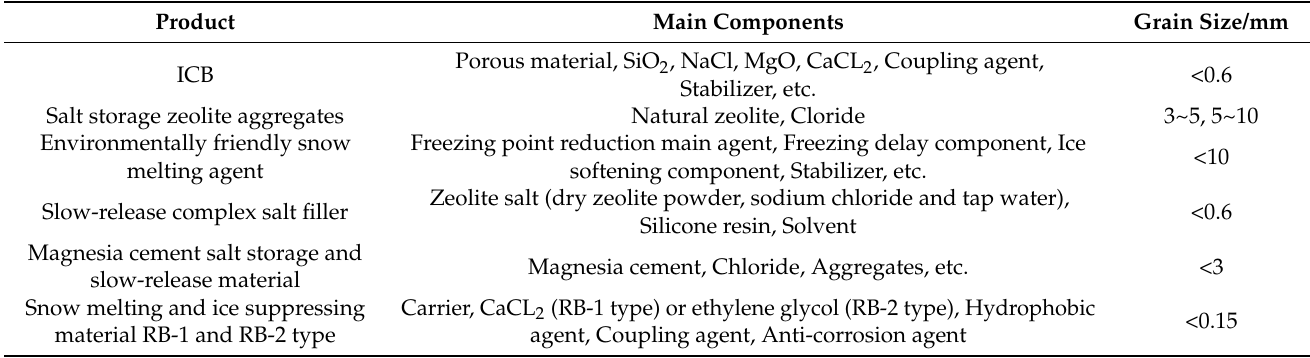
Table 3. Main components of salt-storage